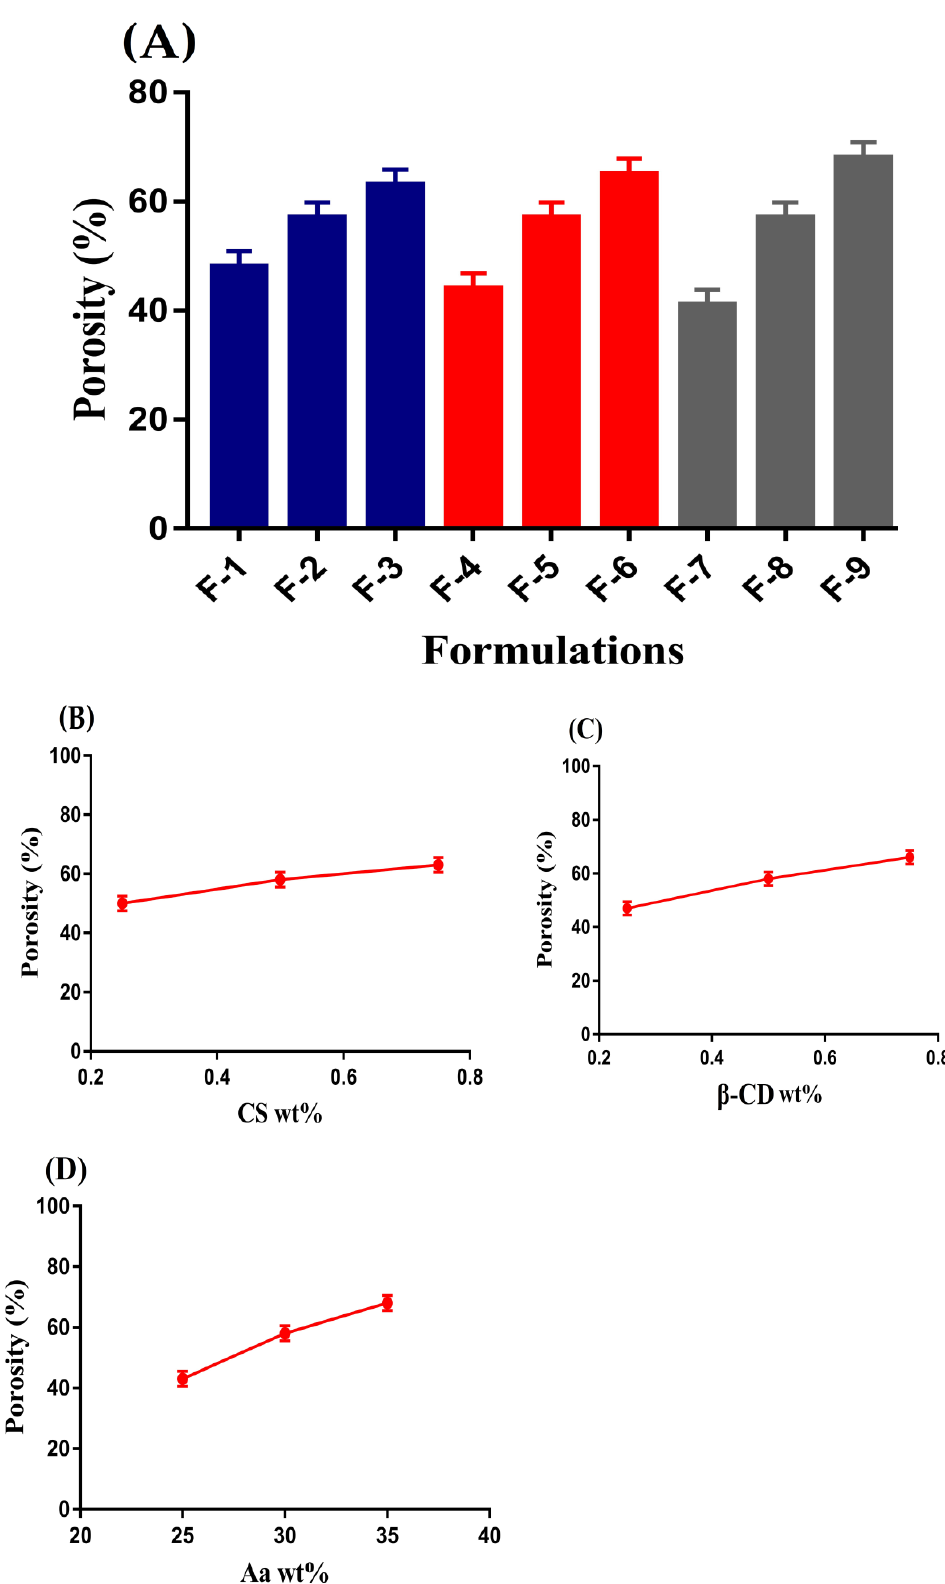
Figure 3. Effect of ( A ) all formulations, ( B ) CS, ( C ) β -CD, and ( D ) Aa on porosity of CS/ β -CDcPAa hydrogel.